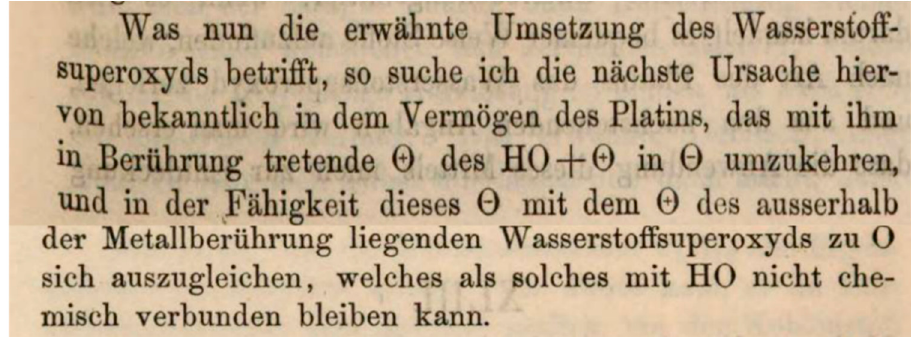
Figure 7. Chemical speculations of the 19th century. Excerpt of the article by Schönbein [2] that tries to explain the catalytic mechanism of peroxidases as analogous to noble metal-induced